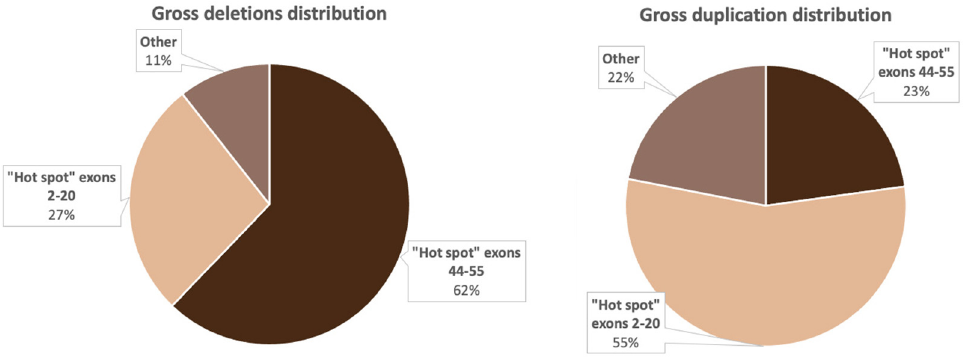
Figure 4. Distribution of the most common deletions and duplications in the DMD gene in Russian patients.